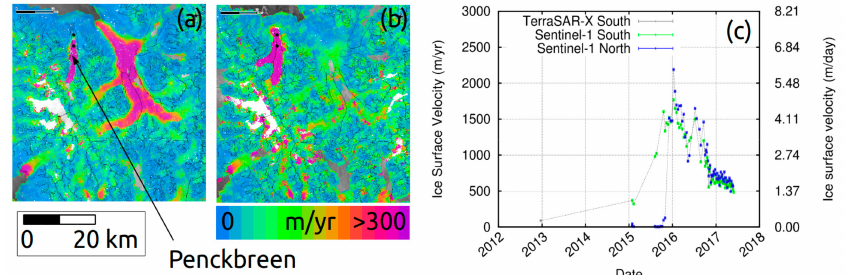
Figure 9. Ice surface velocity maps for Penckbreen on South Spitsbergen (Svalbard) from Sentinel-1 data of the time periods 19/09/2015 to 01/10/2015 ( a ) and 16/02/2017 to 28/02/2017 ( b ) and time-series of velocity for two points (labelled as South and North with respect to their latitude) from 2012 to 2017 ( c ). The two dots indicate the locations used for the time series.